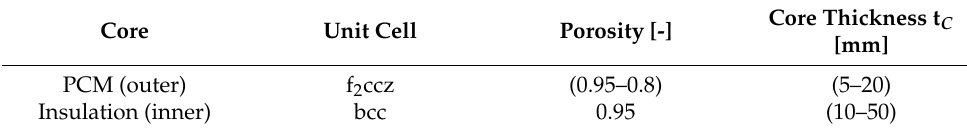
Table 1. Geometrical parameters of the lattice structures with reference to Figure